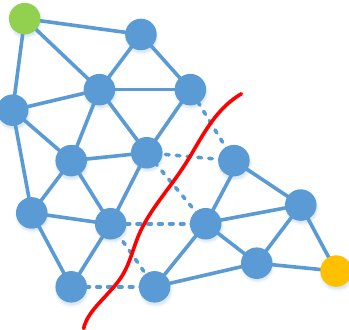
Figure 1: The colored nodes and edges constitute a graph and each edge is associated with a weight. The green and the yellow nodes are two special ones, named as source and sink respec- tively. The red cut separates the graph into two disjoint subsets and each of them contains only source or sink node. The removed edges are dashed in the figure. The minimum cut is a cut whose removed edges have the smallest sum of